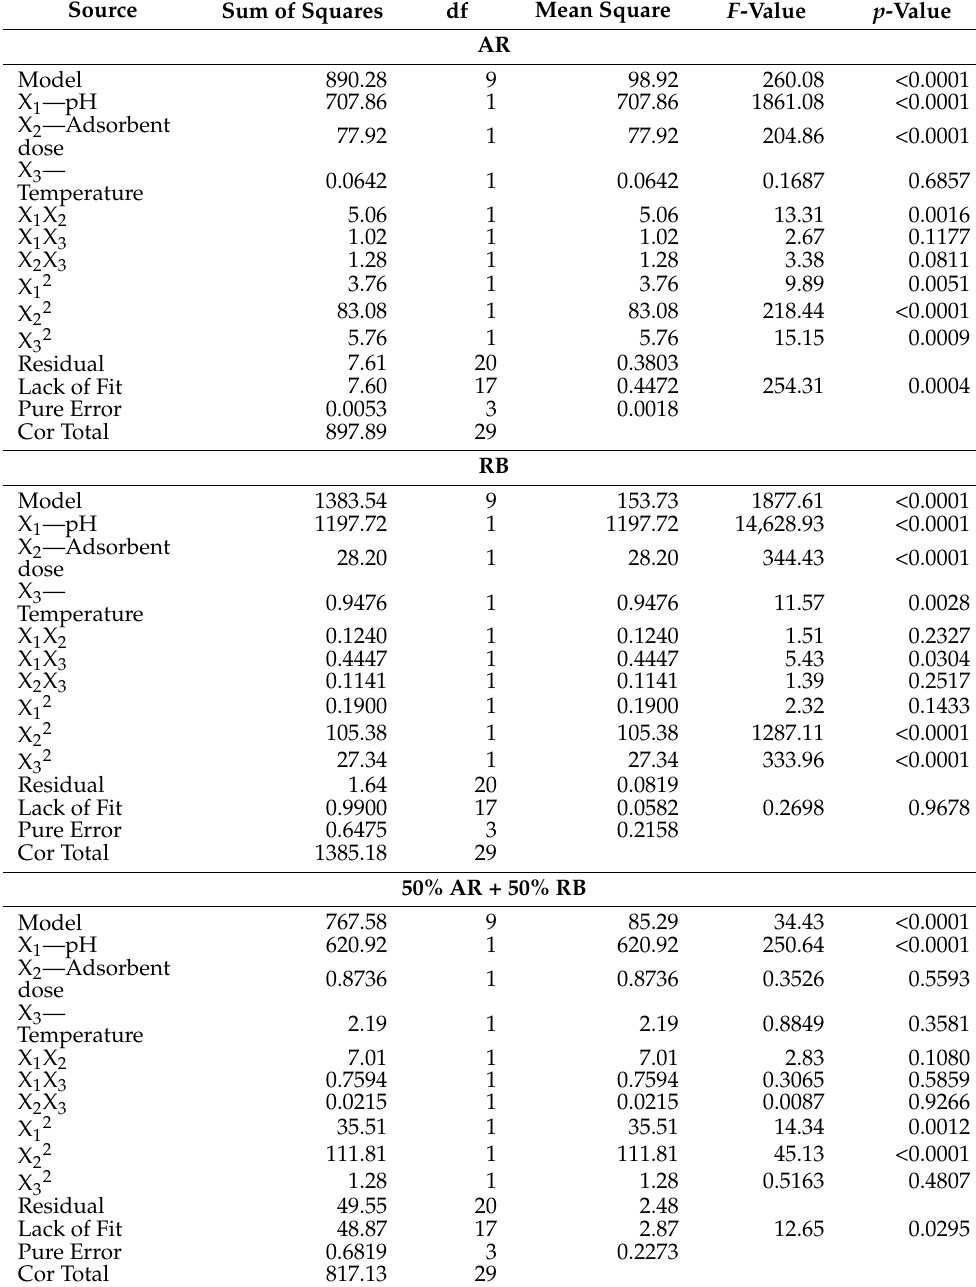
Table 2. Analysis of variance for adsorption of dyes in single or binary system on the synthesized adsorbent